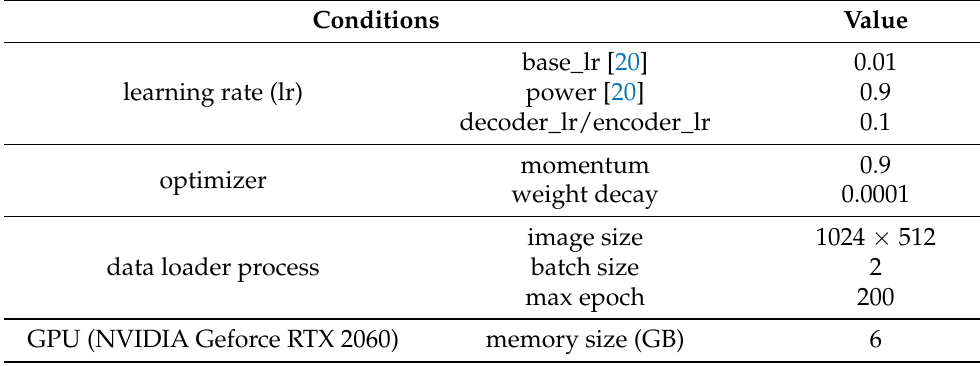
Table 1. Leaning